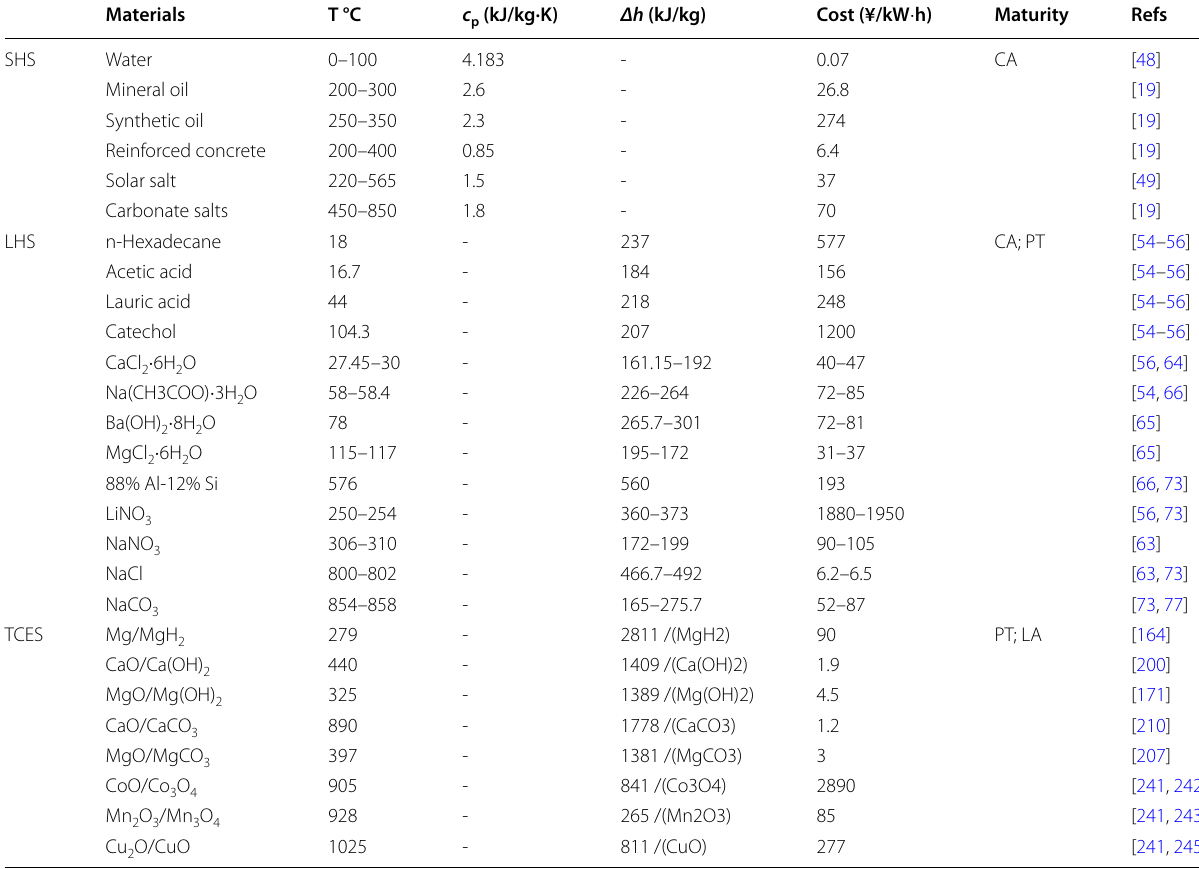
Table 15 Comparison of some typical heat storage methods